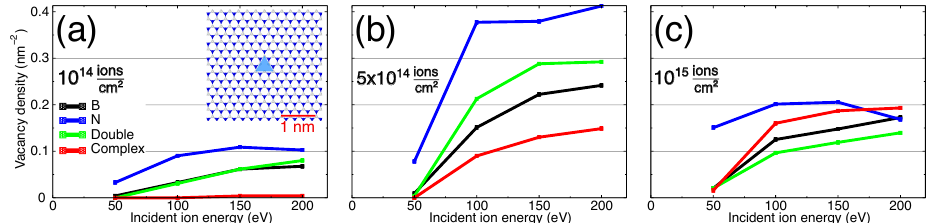
Figure 3. Comparison of the concentration of vacancies in h-BN sheet after irradiation with Ar ions with three different fluences as functions of ion energy: ( a ) 1 × 10 14 , ( b ) 5 × 10 14 and ( c ) 1 × 10 15 ions/cm 2 . The inset in panel ( a ) illustrates the average area for single defect when defect density is 0.1nm − 2